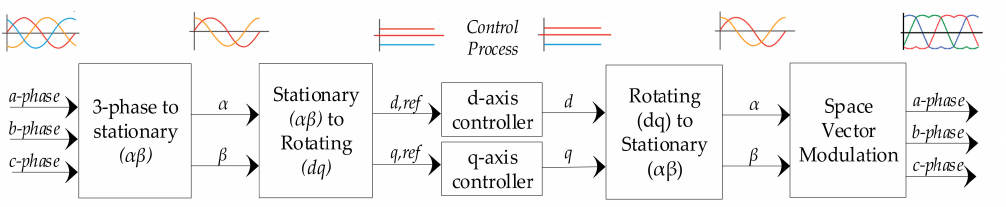
Figure 5. Vector control transformation adopted from reference